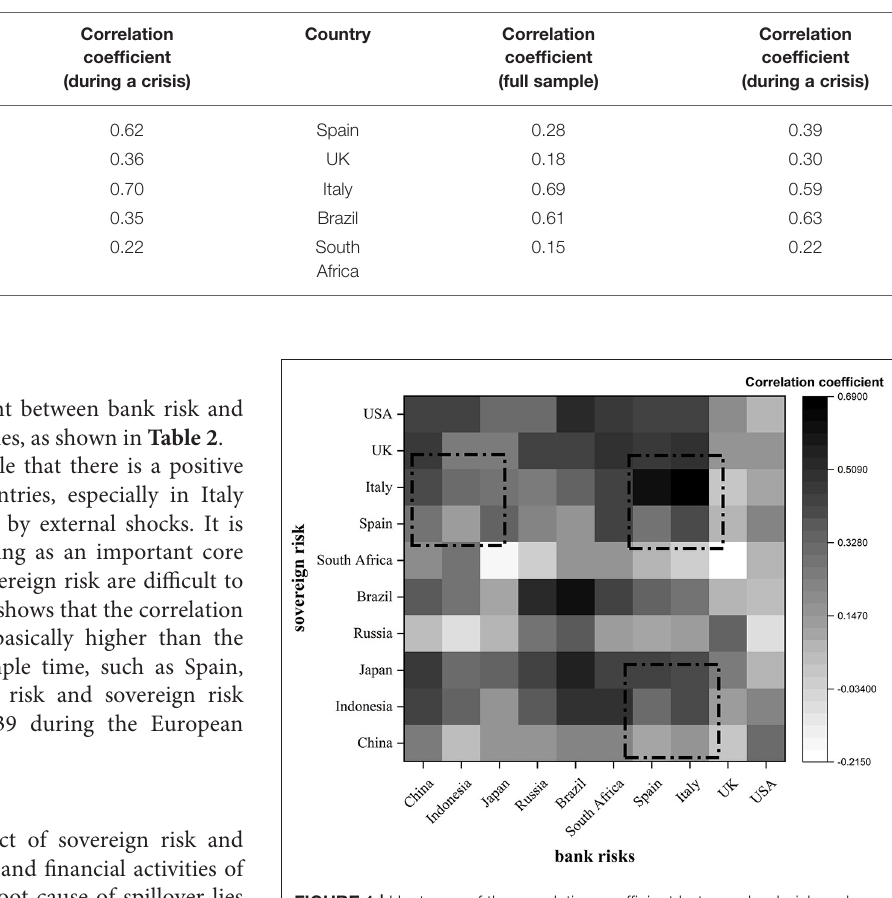
FIGURE 1 | Heat map of the correlation coefficient between bank risk and sovereign